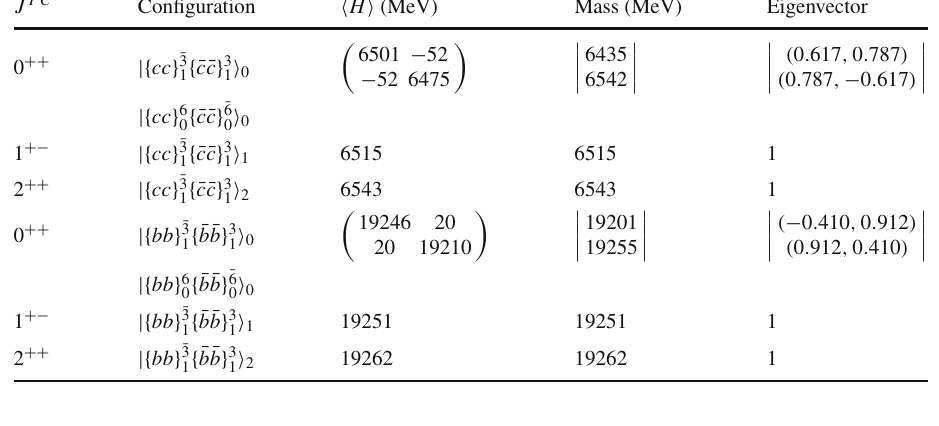
Table 3 The color proportions and the root mean square radii of the ground states for cc ¯ c ¯ c and bb ¯ b ¯ b systems. The units of masses and root mean square radii are in MeV and fm, respectively